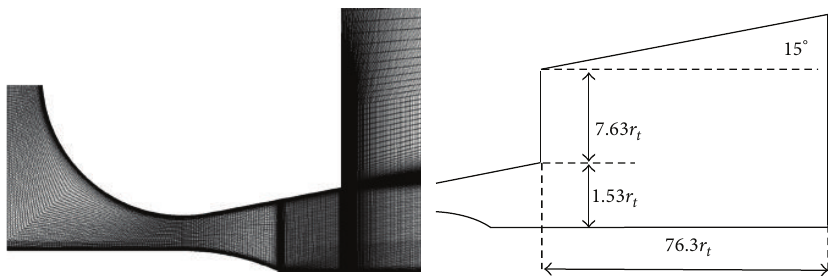
Figure 5: Mesh structure and downstream exhaust flow domain.